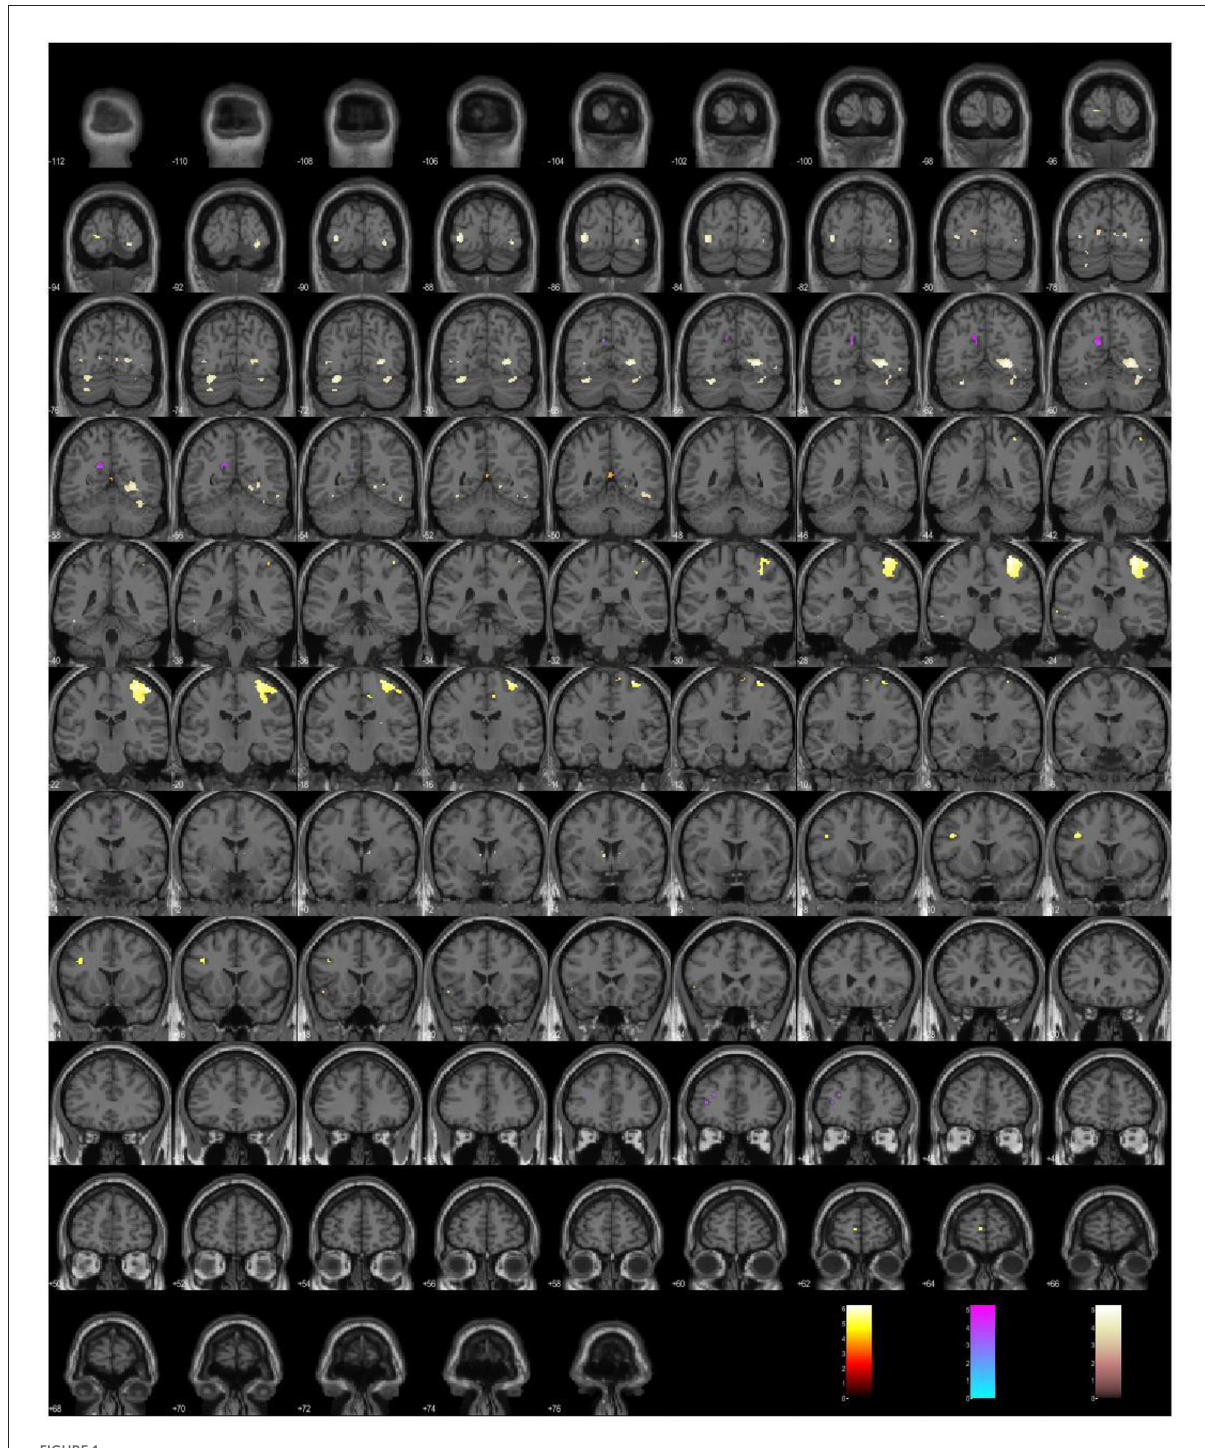
FIGURE1 A plot of the differential activations under the simultaneous administration of psychometric tools: the depressive Scale (hot), the paranoid Scale (cool), the Stroop Color, and the Word Test (pink).